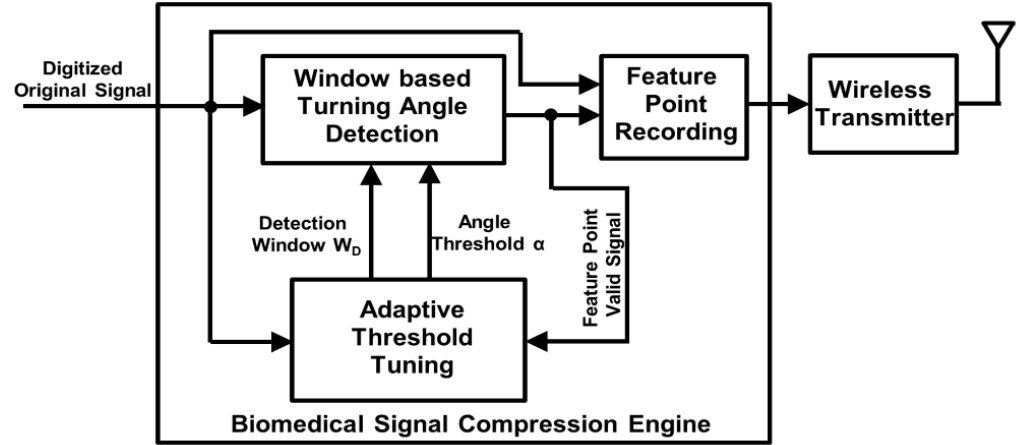
Figure 2. Architecture of the proposed biomedical signal compression engine.